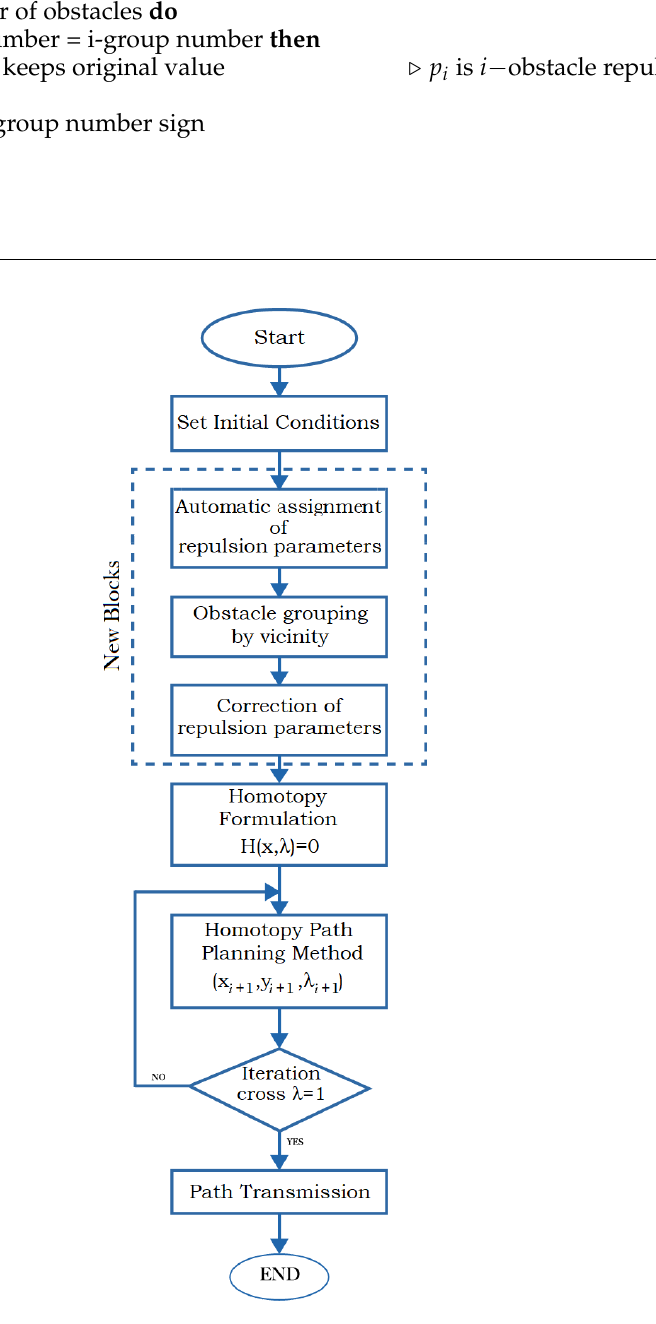
Figure 10. Flowchart of the Finite State